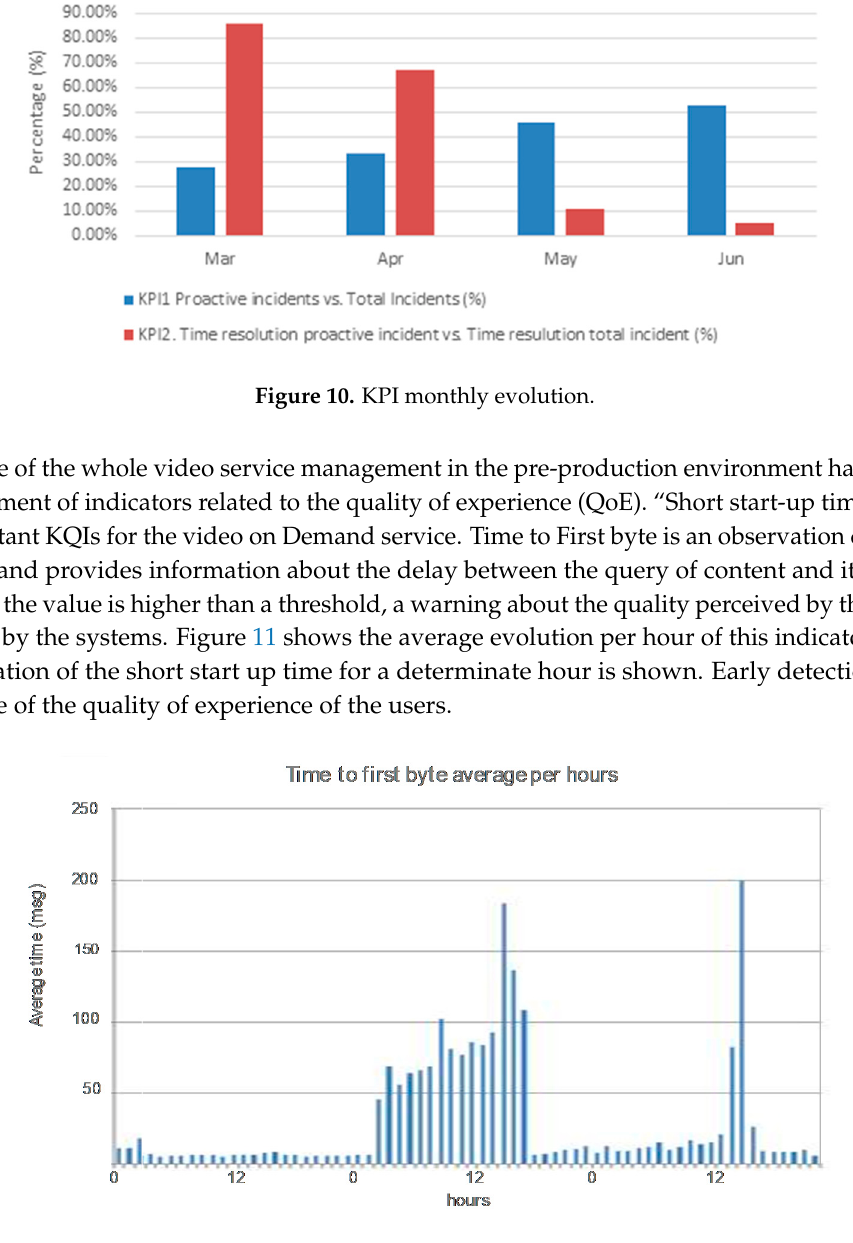
Figure 11. KQI Figure 11. KQI evolution. Figure 11. KQI evolution.